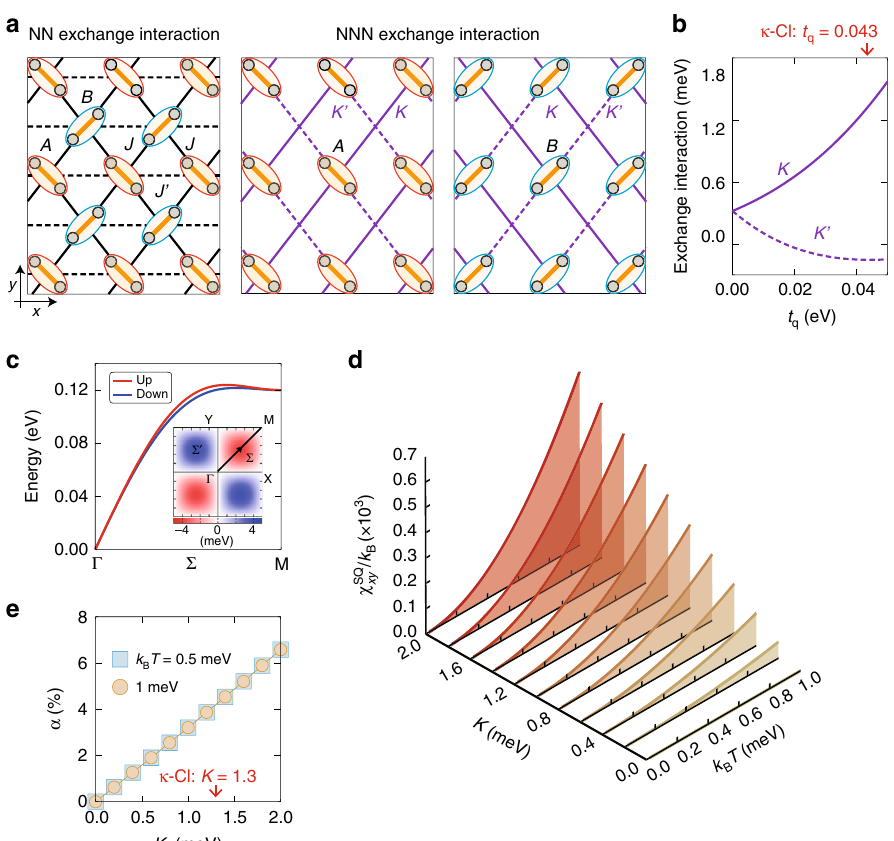
Fig. 4 Effective NNN exchange interactions, magnon dispersions, and heat-spin current conversion in the AFM insulating state. a Real-space distribution of the NN exchange interactions J (solid lines) and J ′ (broken lines) between A and B dimers (left panel) and those of the NNN exchange interactions K (purple solid lines) and K ′ (purple broken lines) between A dimers (middle panel) and B dimers (right panel). b , t dependences of K and K ′ at U ¼ 1 eV. q The red arrow represents the value of t in κ -Cl. c Magnon dispersions at ð J ; J ′ ; K ; K ′ Þ ¼ ð 80 ; 20 ; 2 ; 0 Þ meV within the linear spin-wave theory. The inset q shows a contour map of the spin splitting between the up- and down-spin magnons in the fi rst Brillouin zone. d ð T ; K Þ dependences of the spin current conductivity under a thermal gradient, χ SQ xy . The other exchange interactions and the damping factor are ð J ; J ′ ; K ′ ; η Þ = ð 80 ; 20 ; 0 ; 1 Þ meV. e K dependences T ¼ 0 : 5 meV and 1 meV, where κ y -axis. The red of the heat-spin current conversion rate α ð¼ j 2 J χ SQ xy = _ κ yy jÞ at k yy is the thermal conductivity along the B arrow represents the value of K in κ